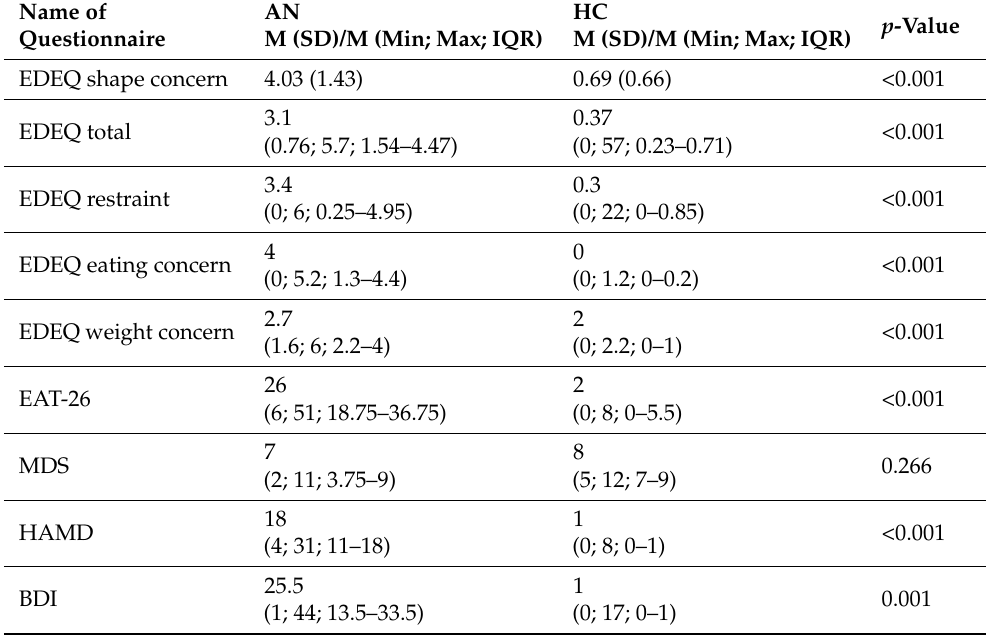
Table 2. Results of psychological questionnaires; AN = anorexia nervosa, HC = healthy controls, M = mean, SD = standard deviation, Min = minimum, Max = maximum, IQR = interquartile rank, EDEQ = Eating Disorder Examination Questionnaire, EAT-26 = Eating Attitude Test-26, MDS = Mediterranean Diet Score, HAMD = Hamilton Depression Rating Scale, BDI = Beck De- pression Inventory.